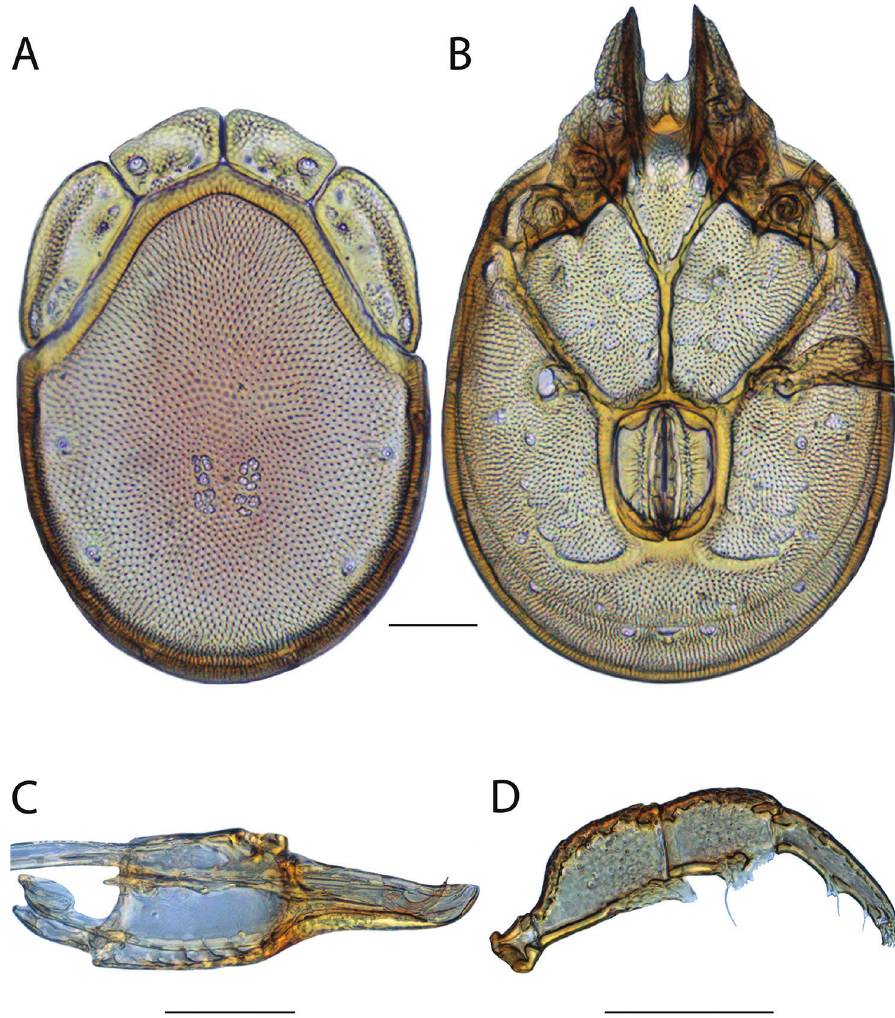
Figure 174. Torrenticola oliveri sp. n. male: A dorsal plates B venter (legs removed) C subcapitulum D pedipalp (setae not accurately depicted). Scale = 100 µm. m ale (Figure 174) (n = 5) (allotypic measurements in parentheses when available) with characters of the genus with following